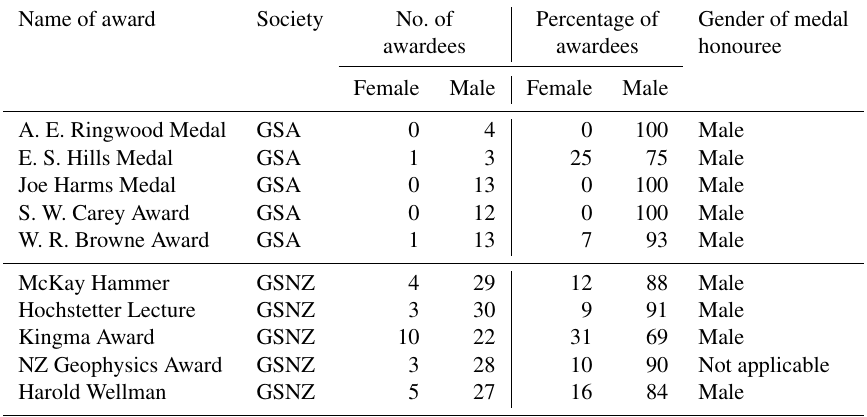
Table 1. Summary of the gender of past award recipients for national and general awards of the Geological Society of Australia (GSA) and Geoscience Society of New Zealand